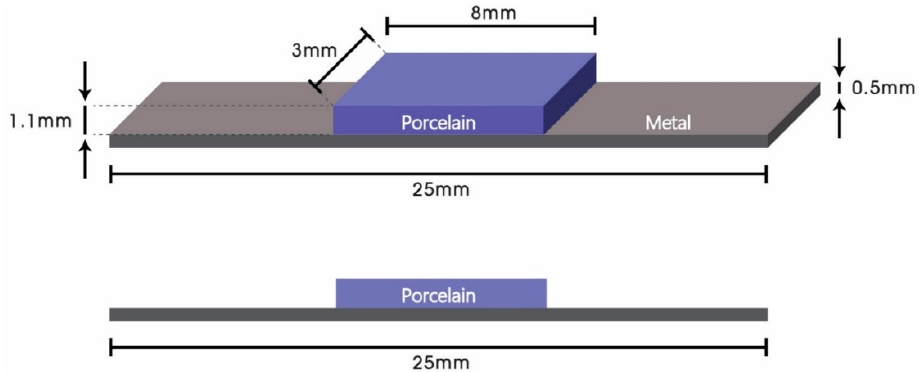
Figure 2. Schematic diagram of metal-ceramic specimens conforming to ISO 9693 guidelines.